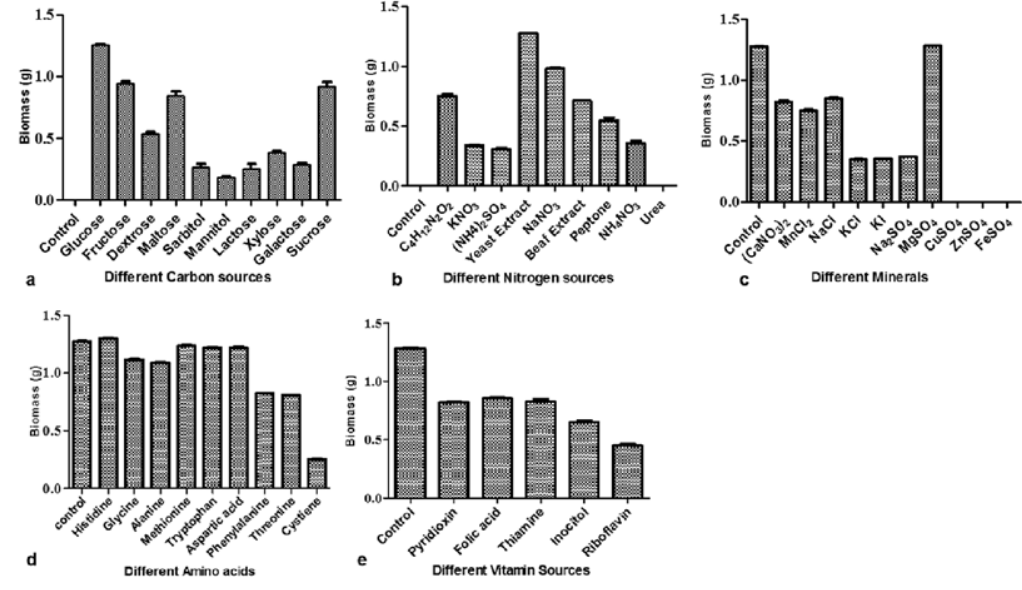
Fig. 3. Growth of M . karstenii in different chemical parameters: (a) carbon; (b) nitrogen; (c) mineral; (d) amino